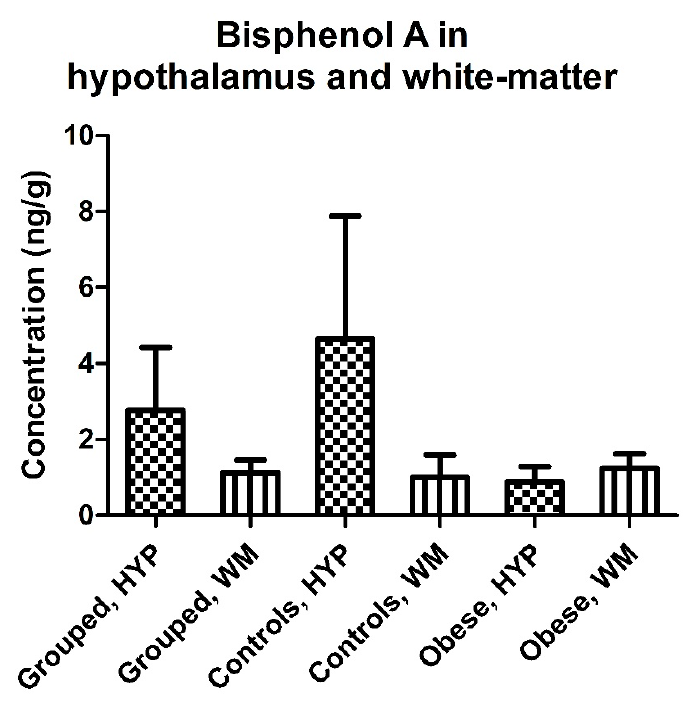
Figure 3. Concentrations (mean ± SD) of bisphenol A (BPA) in hypothalamus and white ‐ matter brain tissue in all paired samples combined, controls, and obese cases.